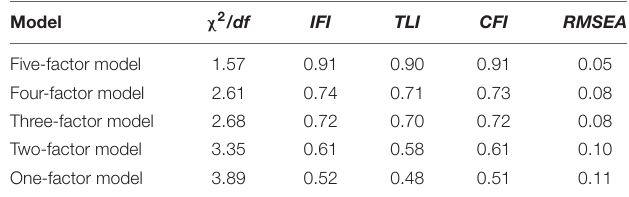
TABLE 2 | Model of the confirmatory factor